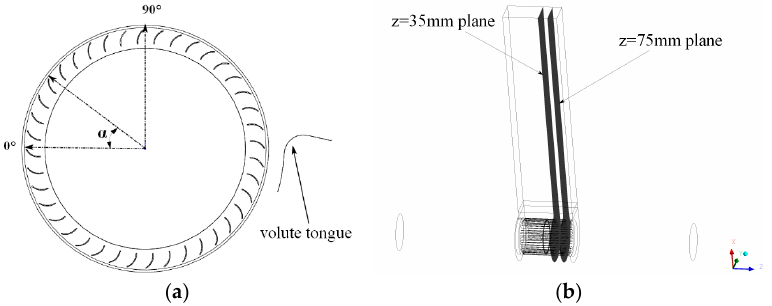
Figure 8. Definitions of the xy -plane ( α is in clockwise direction) and z -plane: ( a ) xy -plane; ( b ) z